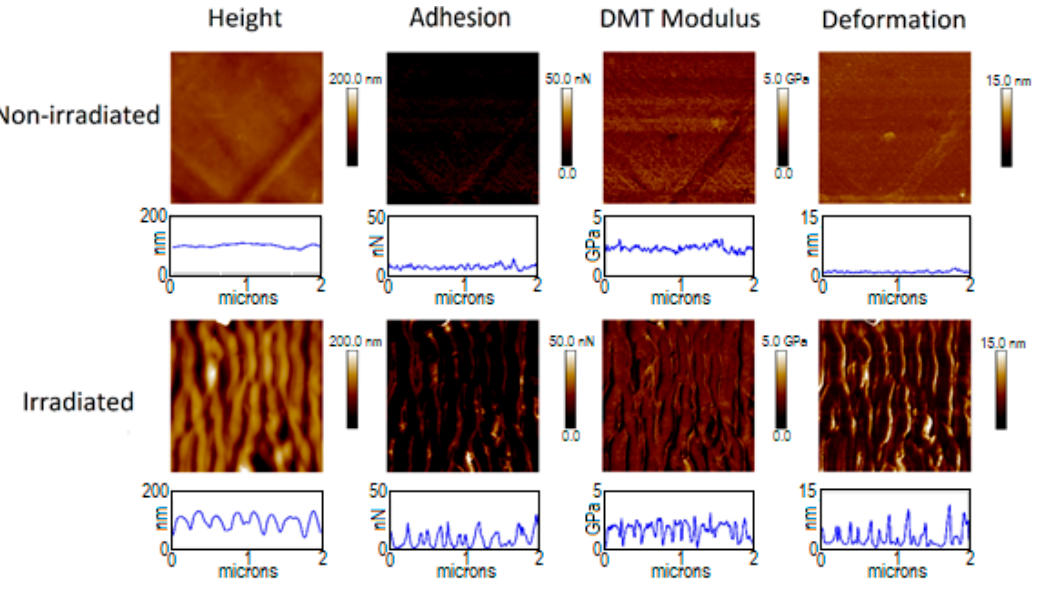
Figure 4. PF-QNM measurements of PTT-WS 2 surfaces before and after irradiated with 5000 pulses at 20.3 mJ/cm 2 . (2 × 2 μ m 2 images and property profiles over a 2 μ m horizontal line). Table 5. Measurements of the deformation, adhesion and Young’s Modulus (E) obtained with PF-QNM for non-irradiated samples and samples irradiated with 5000 pulses and a fluence of 20.3 mJ / cm 2 .